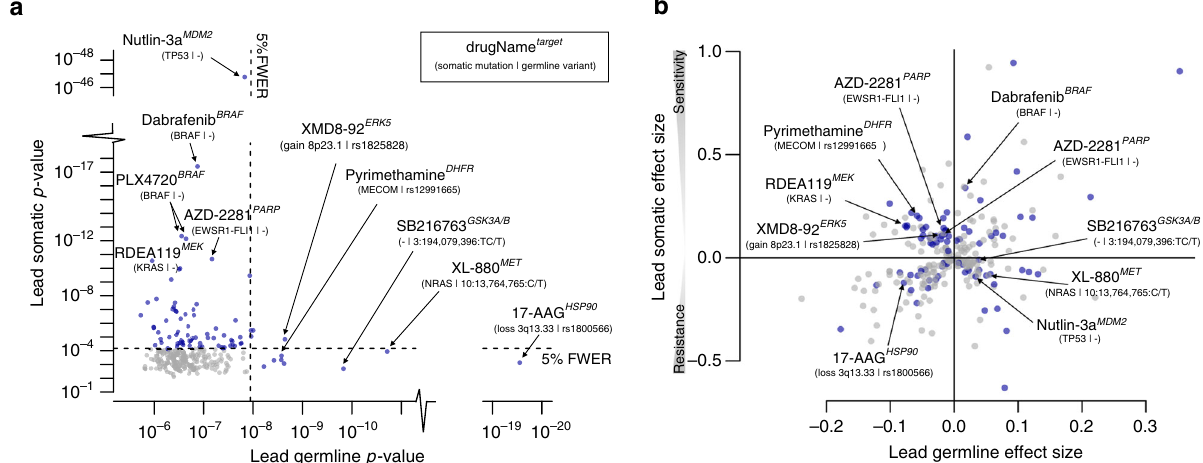
Fig. 2 Germline and somatic associations with drug susceptibility. a Negative log P values from genome-wide association analyses with drug susceptibility phenotypes of 265 drugs, either considering lead germline variants ( x -axis) or lead somatic mutations ( y -axis). Shown are lead associations, i.e., the most signi fi cant association for either QTL type for each drug. b Effect size estimates for the associations shown in a , considering the corresponding lead germline associations ( x -axis) or lead somatic associations ( y -axis). Each dot represents a drug. Drugs coloured in blue have a signi fi cant germline or somatic association (FWER < 0.05). Somatic QTLs tended to have large effect sizes than germline QTLs. (See also Supplementary Fig. 5 for an analysis strati fi ed by variant